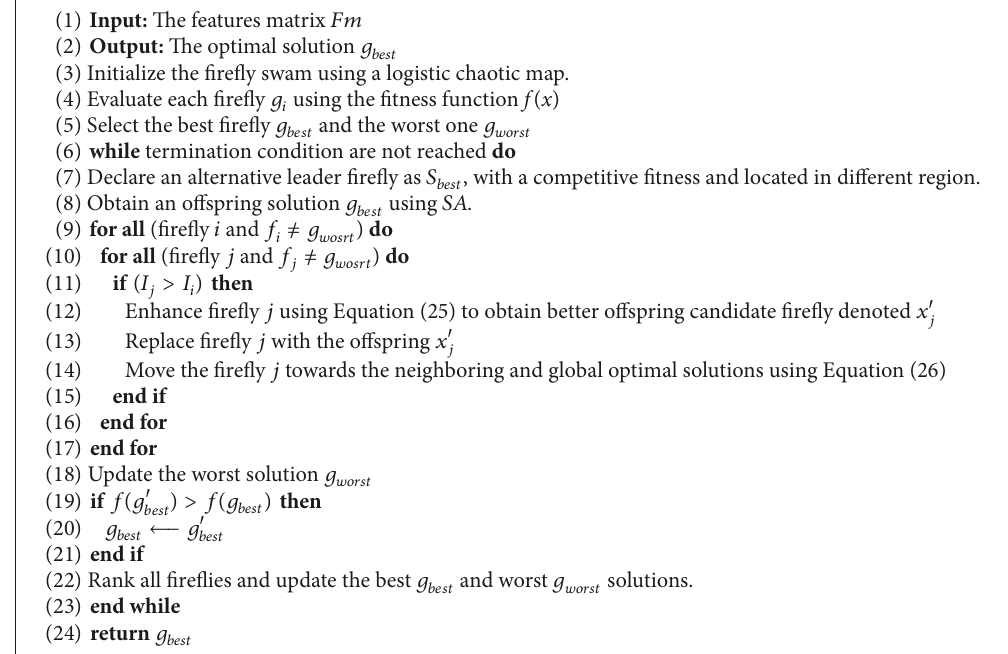
Algorithm 1: The pseudocode of the proposed feature reduction algorithm based on firefly optimization and